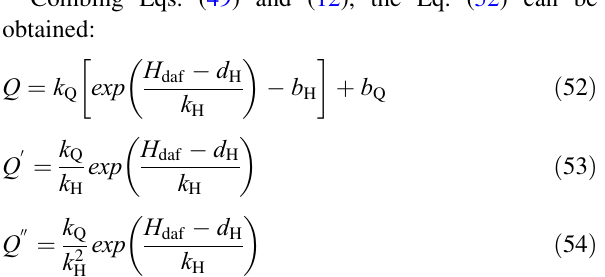
Fig. 12 Variation of H content with vitrinite reflectance R o ; max .